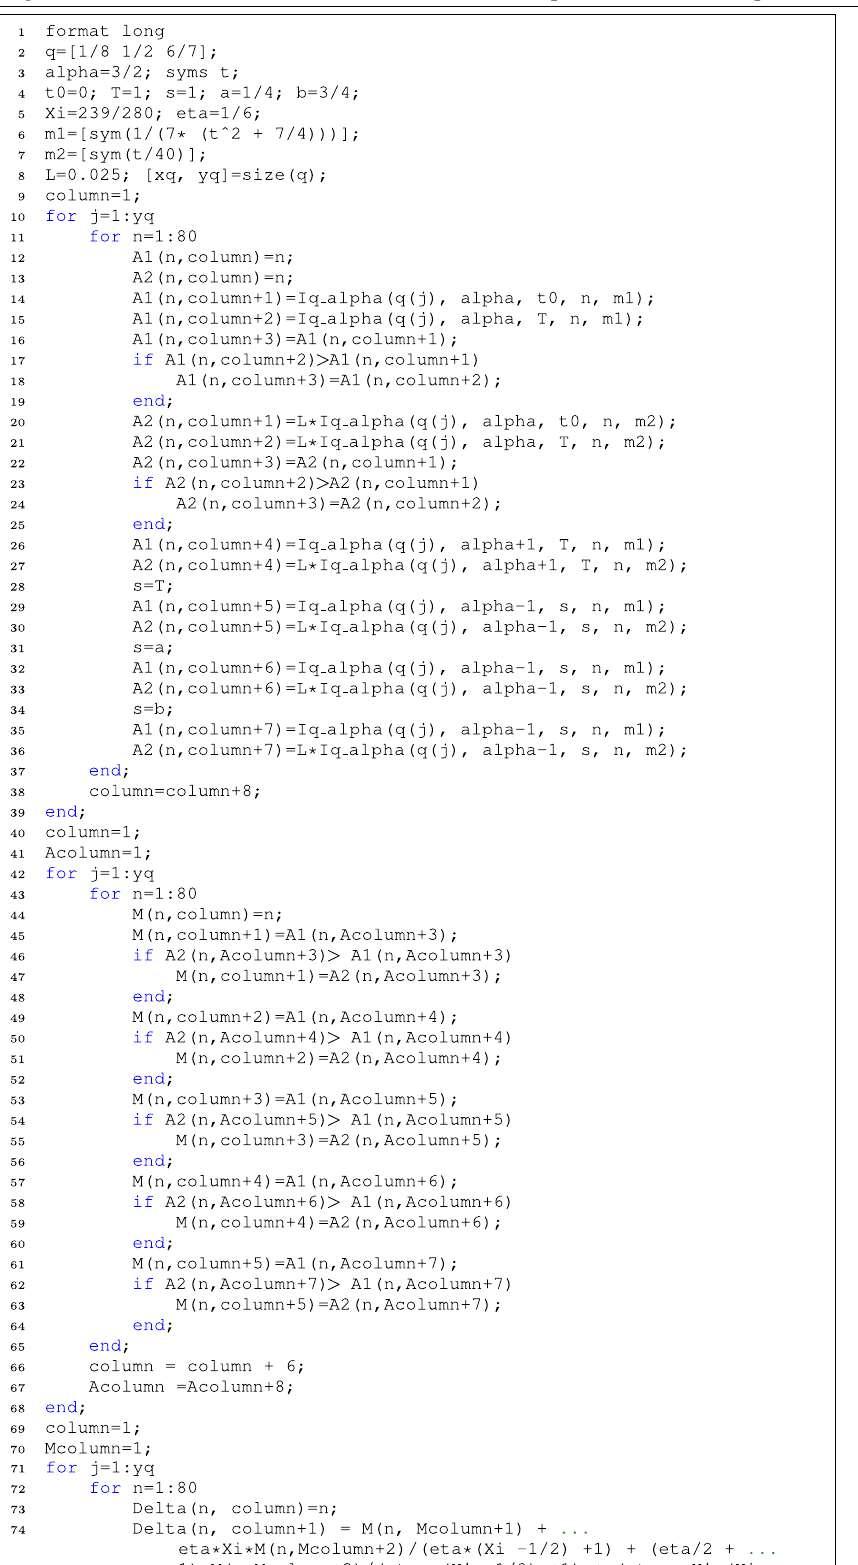
Algorithm 6 The MATLAB lines for calculation of all parameters in Example